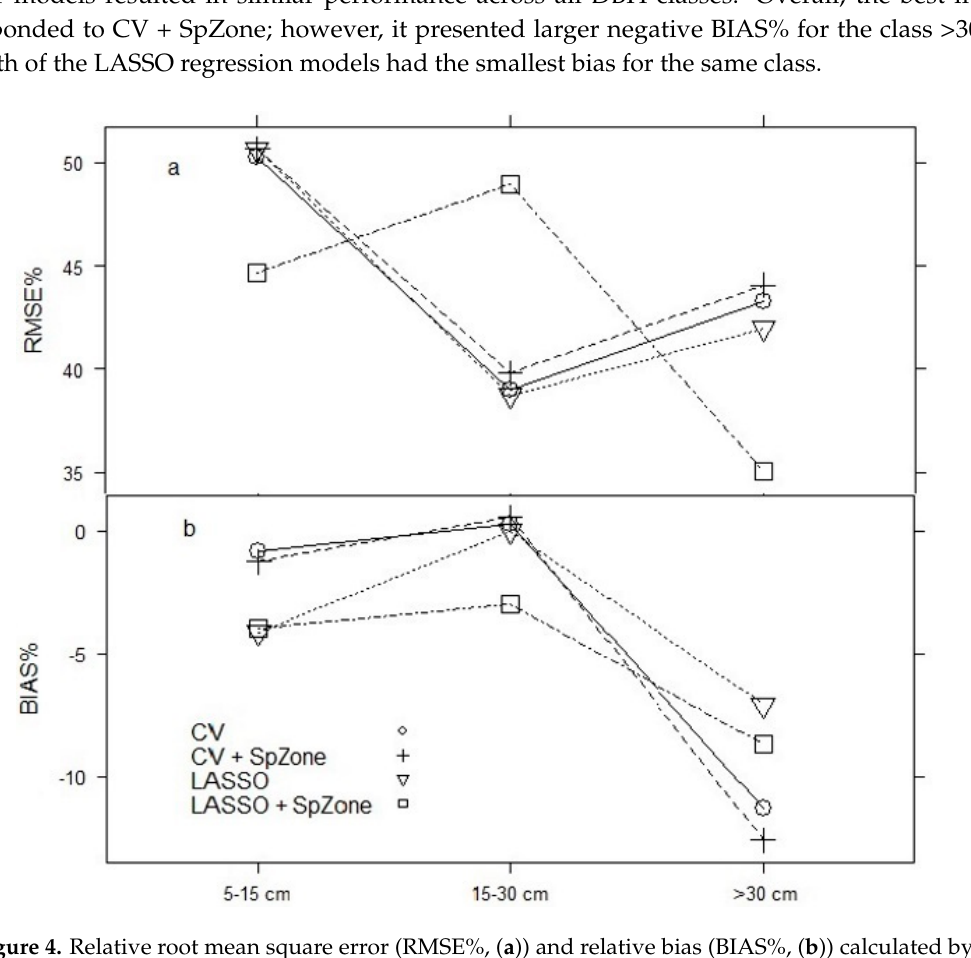
Figure 4. Relative root mean square error (RMSE%, ( a )) and relative bias (BIAS%, ( b )) calculated by DBH classes for selected models using the test dataset.